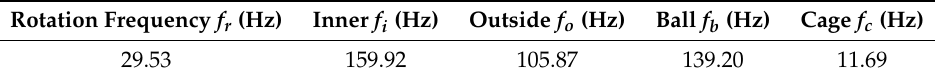
Table 3. Bearing characteristic frequencies.